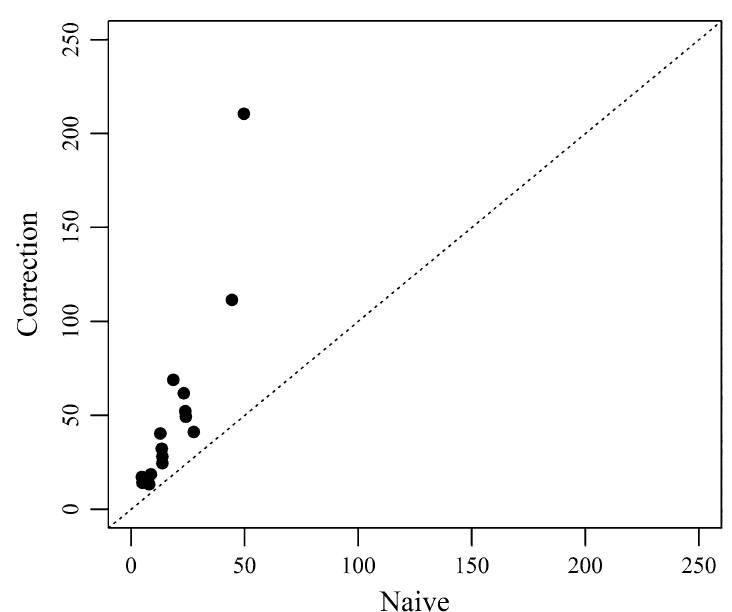
Fig. 2 Reading naive and correction model parameters for the SES Index. Note. Parameter estimates are the posterior mean